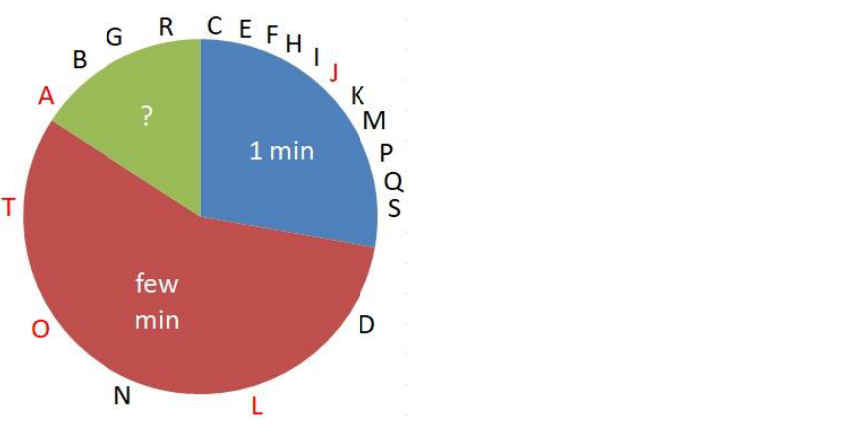
Figure 4. Approximate delay in the onset of CPR measures in 126 CA victims. For 20 cases (16%, ?), no information was available to assign them to sectors ‘1 min’ or ‘few min’. Twenty cases with detailed memories during or shortly after CA (capitals, those with ≥ 7 Greyson points in red) distributed non-randomly over the three sectors ( χ 2 10.74, 2 degrees of freedom, p < 0.005).